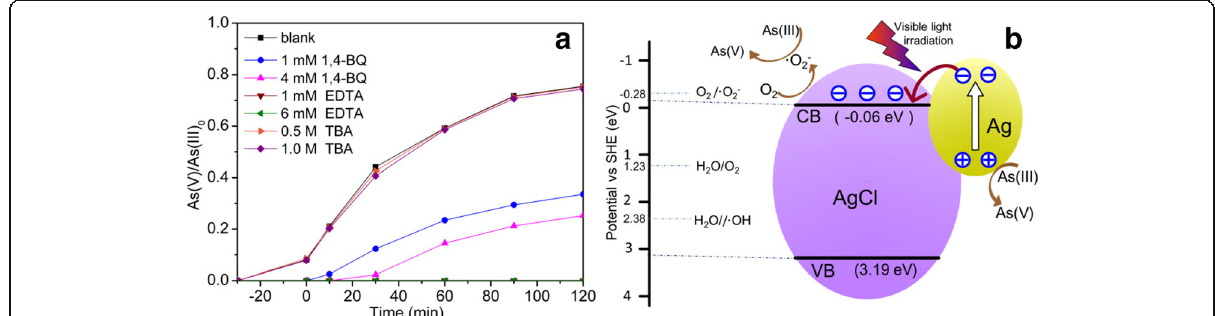
Fig. 8 a Effects of different scavengers on photocatalytic oxidation of As(III) by Ag@AgCl with 120 min visible-light irradiation. Ag@AgCl core – shell nanowires synthesized with the mole ratio of Ag nanowires:FeCl 3 =2.32:2.20, and the experimental conditions were [Ag@AgCl]=0.3 g/L, [As(III)] 0 = 2.0 mg/L, and initial pH=7.0, P =300 W. b Schematic diagram of electron – hole pairs separation and the possible reaction mechanism over Ag/AgCl core – shell nanowires under visible-light